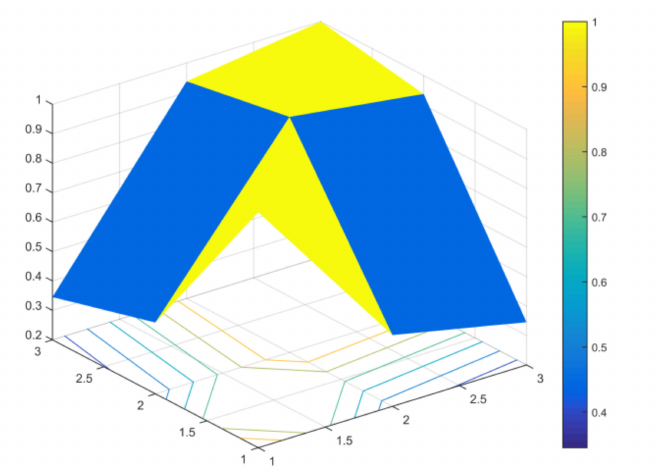
Figure 8. Graphical representation of the (spatial) correlation matrix of the pixel vector arrays for H. sosnowskyi plants and other